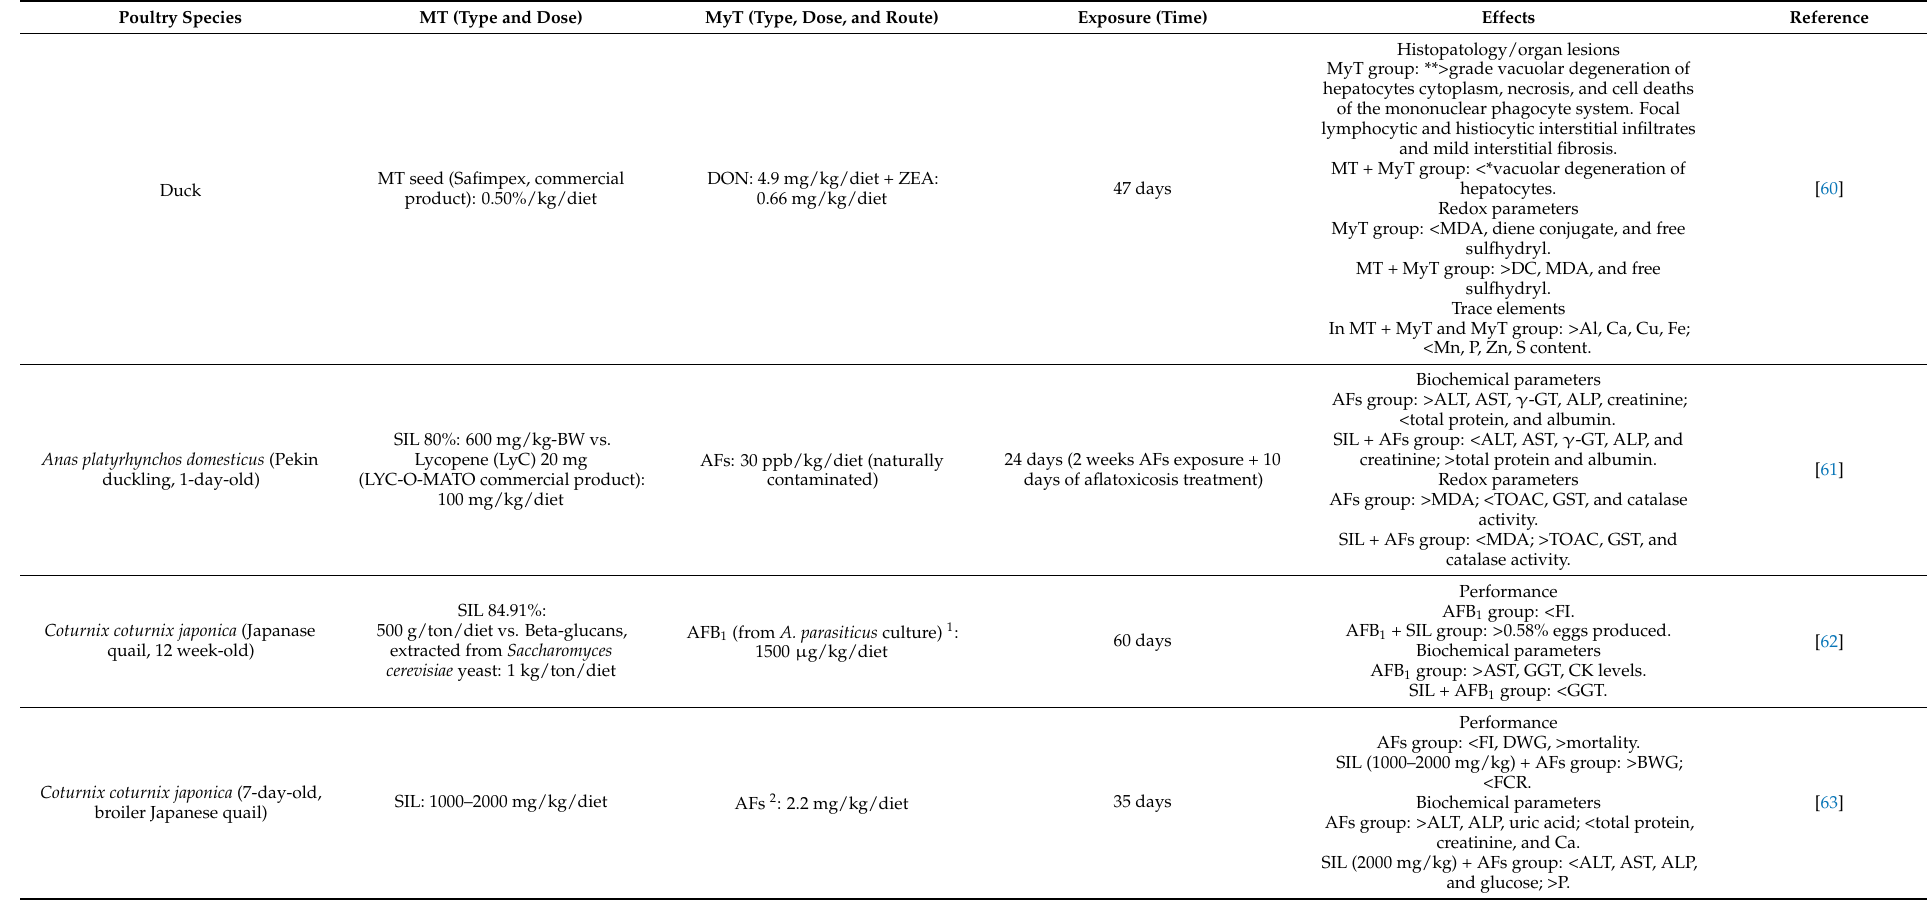
Table 2. Effects of milk thistle (MT) in other poultry species, poisoned by different types of mycotoxins (MyT). If not diversely reported in the section effects the results are referred to the control group without